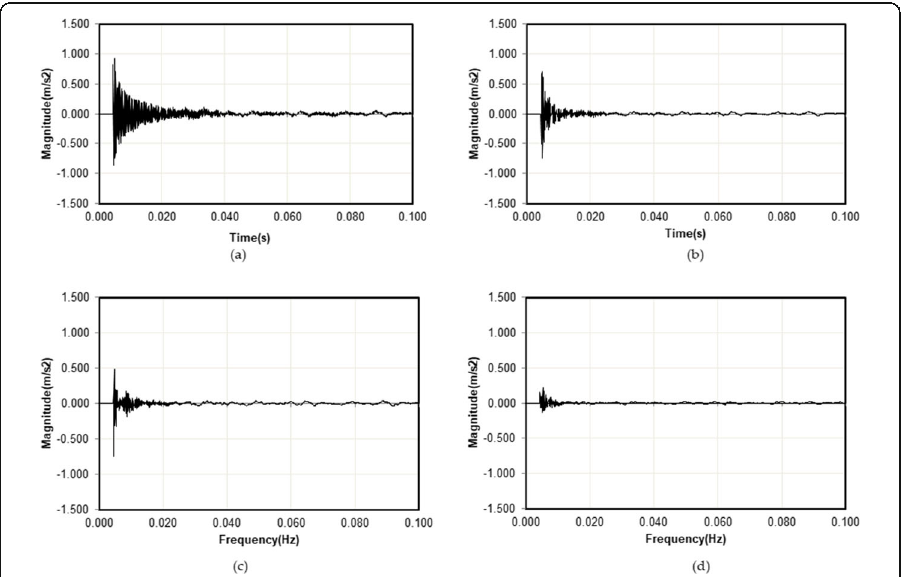
Fig. 14 Acceleration signals with time by cavity size. a 5 cm × 5 cm × 5 cm. b 5 cm × 5 cm × 1.25 cm. c 5 cm × 5 cm × 0.75 cm. d No